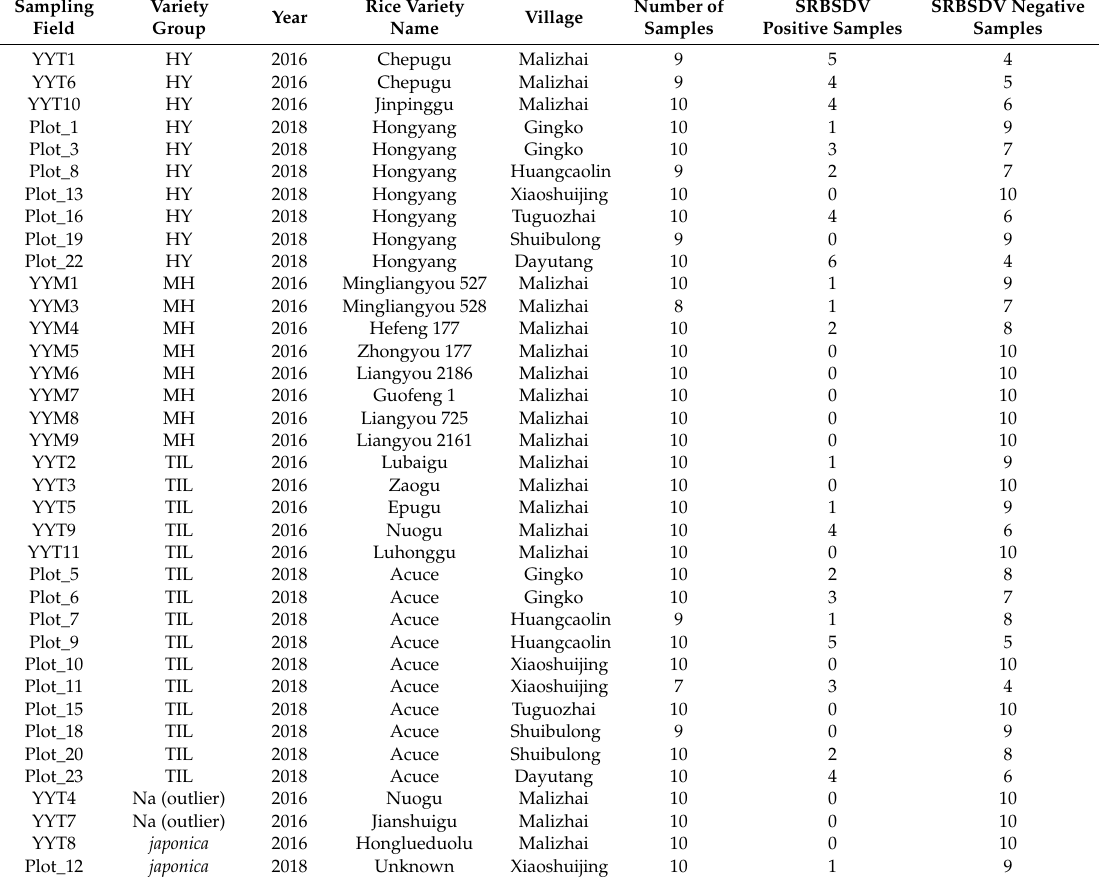
Table 1. Genotyping of rice varieties from the Yuanyang rice terraces of China and screening of these varieties for the presence of Southern rice black-streaked dwarf virus using quantitative real-time PCR (qPCR) assays. HY: Hongyang improved modern variety group, MH: modern hybrid variety group, SRBSDV: Southern rice black-streaked dwarf virus, TIL: traditional indica landraces group and Na: not